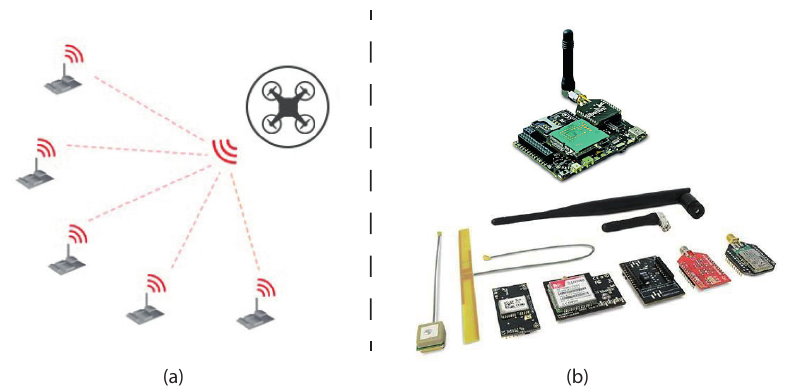
Figure 3. Wireless Sensor Network concept ( a ) and communication devices ( b